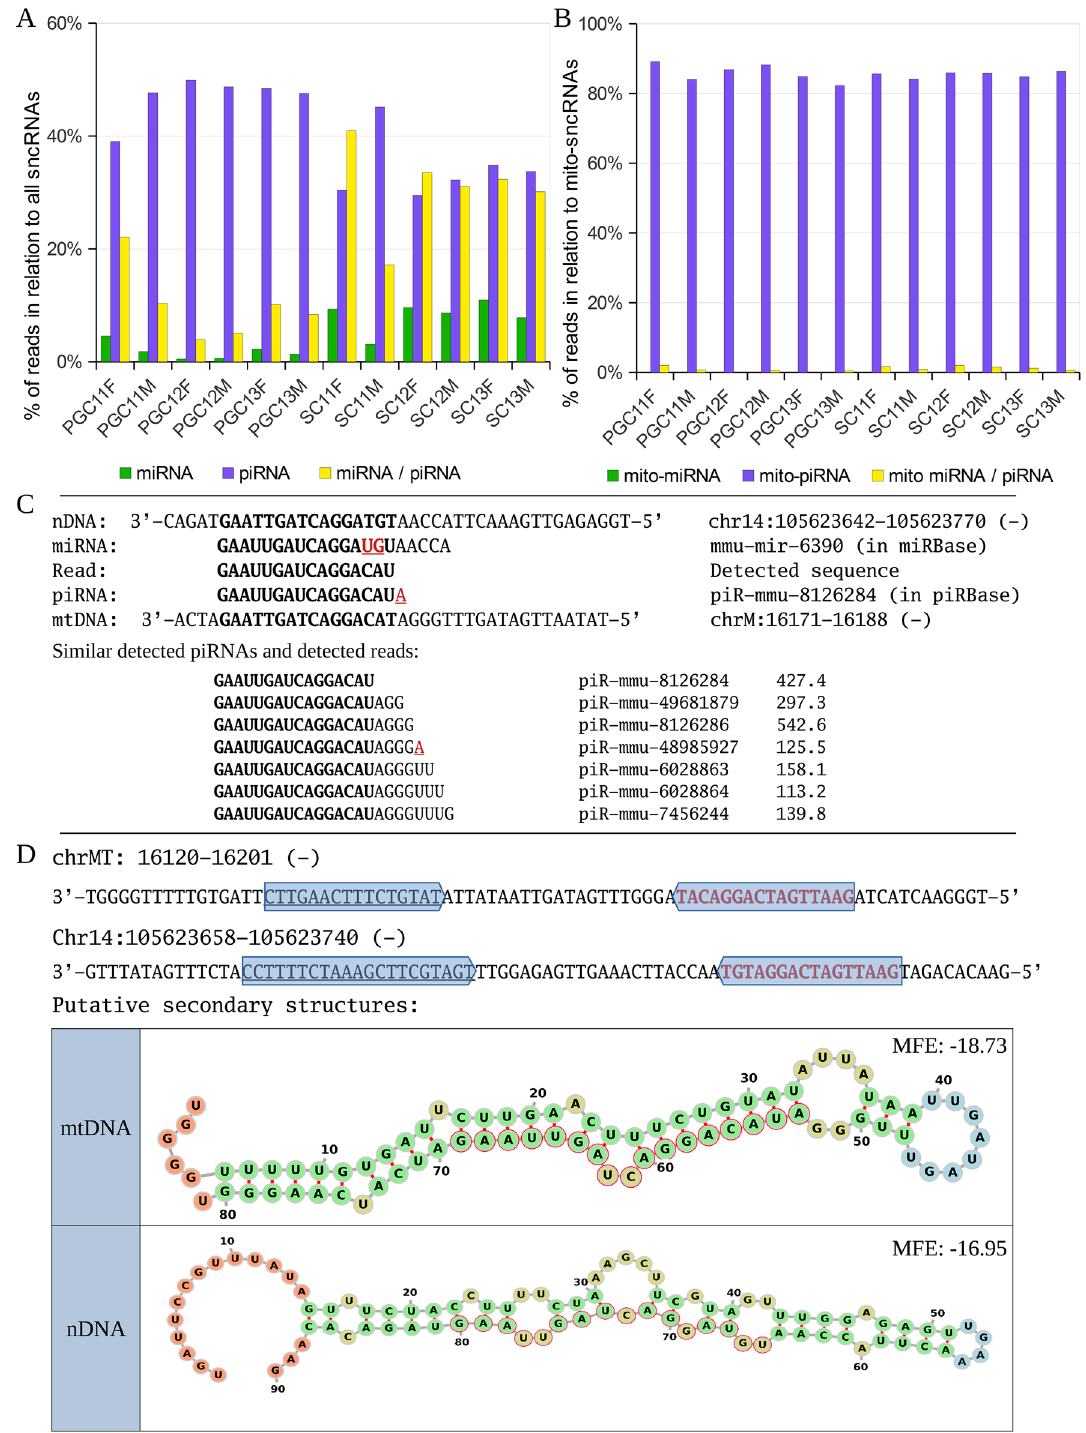
Figure 4. ( A ) Distribution of miRNAs, piRNAs, and dual miRNA/piRNAs in the samples analyzed from both germ (PGCs) and somatic cells (SCs) from the total of sequenced sncRNAs. ( B ) The same distribution corresponding only to the mito-sncRNAs. ( C ) Mapping of mmu-mir-6390/piR-mmu-8126284 and other related mito-piRNAs in both nuclear and mitochondrial genomes. The read counts are expressed as means between all samples. ( D ) Potential secondary RNA structure of the region containing mmu-mir-6390/piR-mmu-8126284 sequences. The Minimum Free Energy (MFE) is expressed in kcal/mol and calculated by RNAfold software with custom